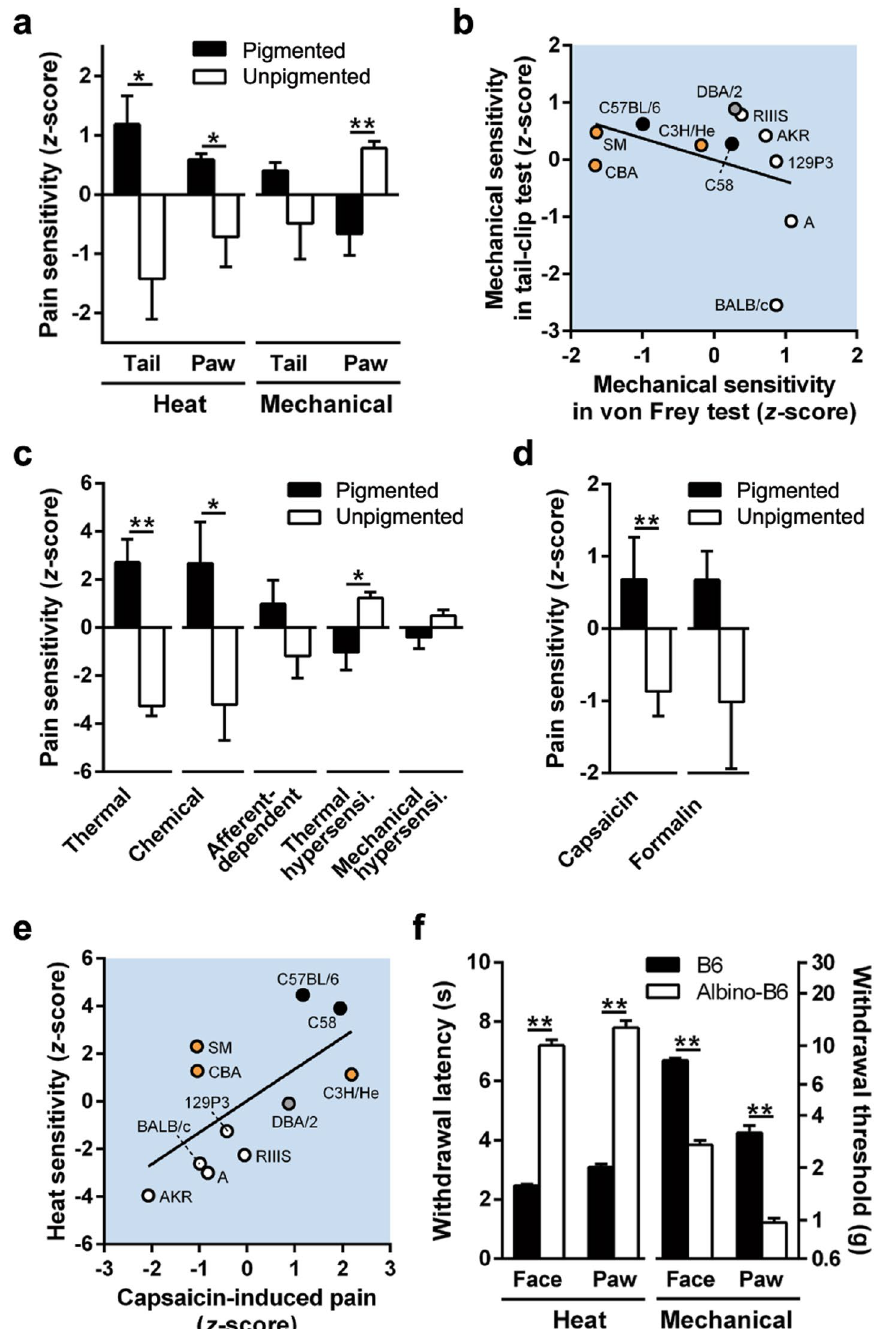
Figure 2. Pigmented and unpigmented mice display differences in cutaneous sensitivities. All bars show mean ± s.e.m. The colour of each plot represents the body colour of the inbred mouse strain. ( a ) Heat and mechanical sensitivities in the tail and paw of pigmented and unpigmented male mice (6 and 5 strains, respectively). Increased pain sensitivity to stimuli is depicted by positive z -scores. ( b ) There is no correlation between mechanical sensitivities as measured by tail-clip and von Frey tests ( r = − 0.38, P < 0.25). ( c ) The sensitivities across 5 different pain modalities (thermal, chemical, afferent-dependent, thermal hypersensitivity and mechanical hypersensitivity) in pigmented and unpigmented mouse groups (6 and 5 strains, respectively) are displayed. The latter three modalities are pathological pain sensitivities in neuropathic and/or inflammatory models. * P < 0.05 and ** P < 0.01, in t -test. ( d ) Capsaicin and formalin sensitivities between pigment and unpigmented mouse groups (6 and 5 strains, respectively). ** P < 0.01, in t -test. ( e ) There is a positive correlation between capsaicin-induced pain and heat sensitivity. Pearson r = 0.81, P < 0.01. Pigmented mouse strains show higher thermal and capsaicin sensitivities. ( f ) Withdrawal latency to radiant heat stimulation and threshold to von Frey filaments in the whisker pad (face) and paw of B6 ( n = 5 and 10, respectively) and albino-B6 ( n = 65 and 30, respectively) female mice. * P < 0.05 and ** P < 0.01, in t